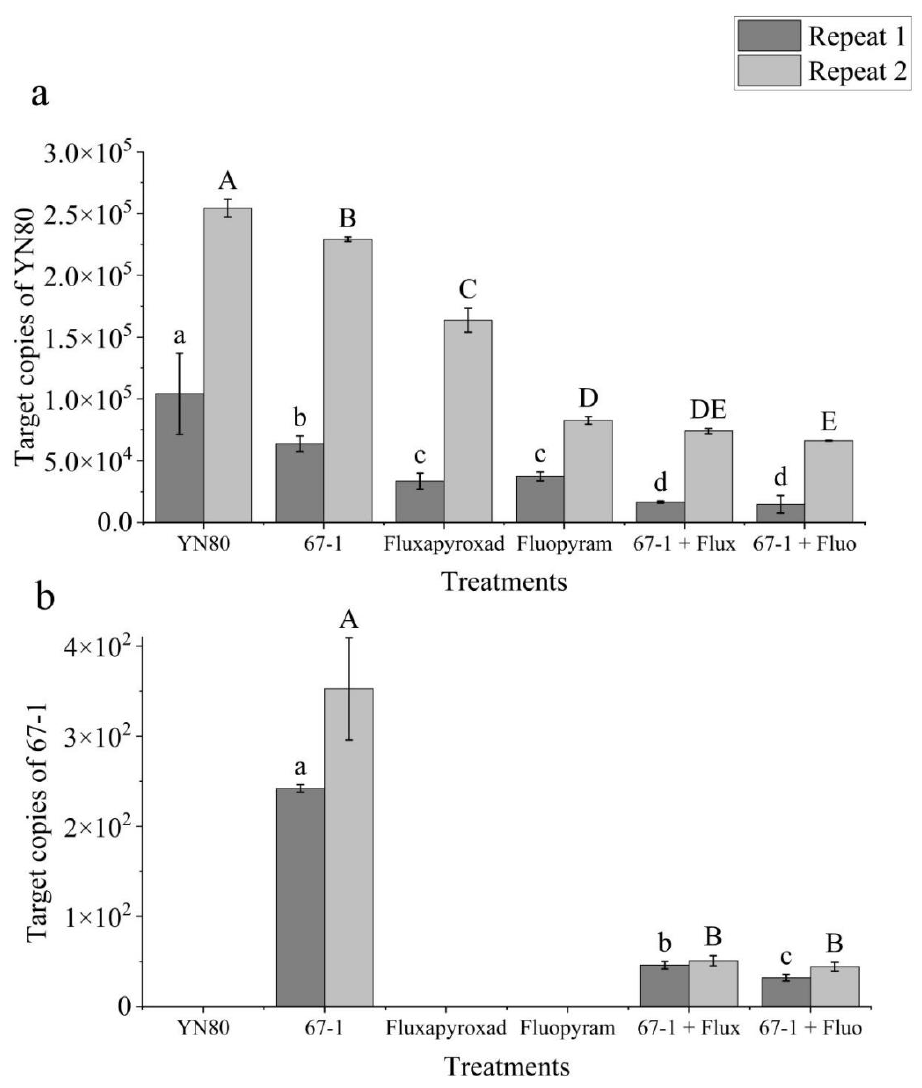
Figure 5. Quantification of Botrytis cinerea ( a ) and Clonostachys rosea ( b ) by TaqMan qPCR in treated tomato plants after 10 days under greenhouse conditions. Data are presented as the mean ± standard deviation (SD). Uppercase letters and lowercase letters represent two independent repeated tests. The different letters indicate significant differences between different treatments in each repeat ( α =